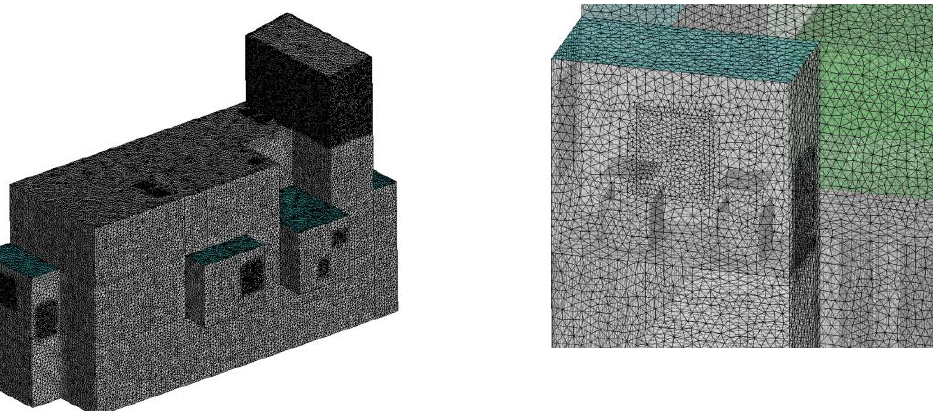
Figure 8. Perspective view of three-dimensional model of project interior space. Figure 8. Analysis of the outdoor wind speed and wind pressure outside the building.